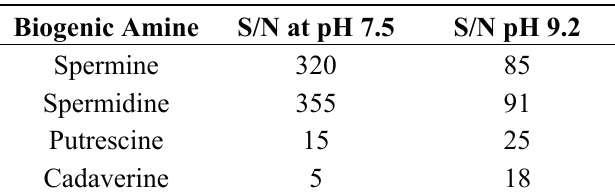
Table 1. Comparison of signal to background ratios of 10 µM analyte in the presence of tetraborate